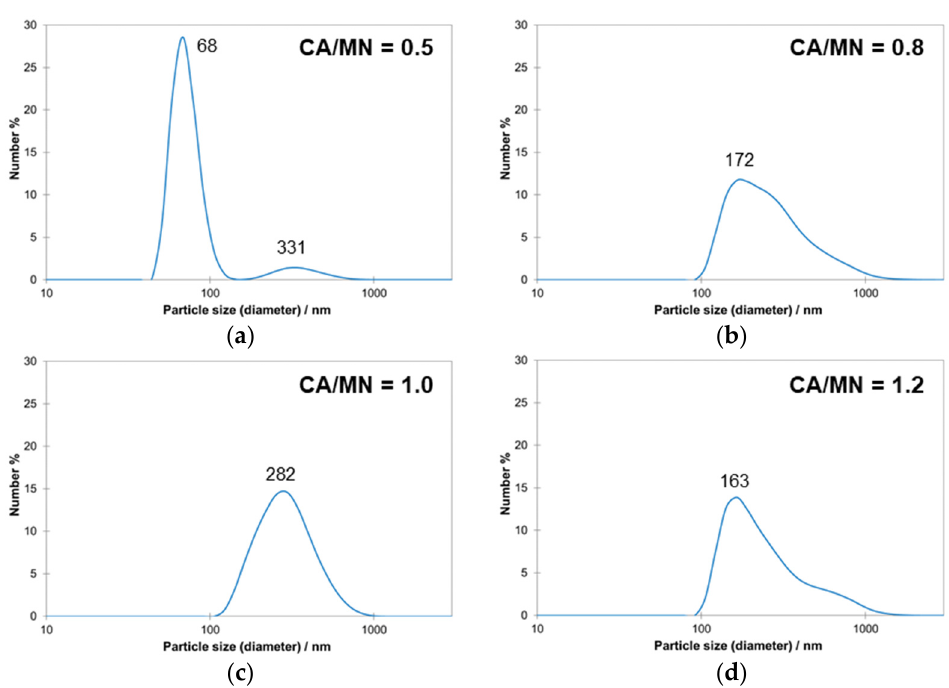
Figure 5. Particle size distributions of spinel powders synthesized at CA/MN ratios of ( a ) 0.5, ( b ) 0.8, ( c ) 1.0, and ( d ) 1.2.